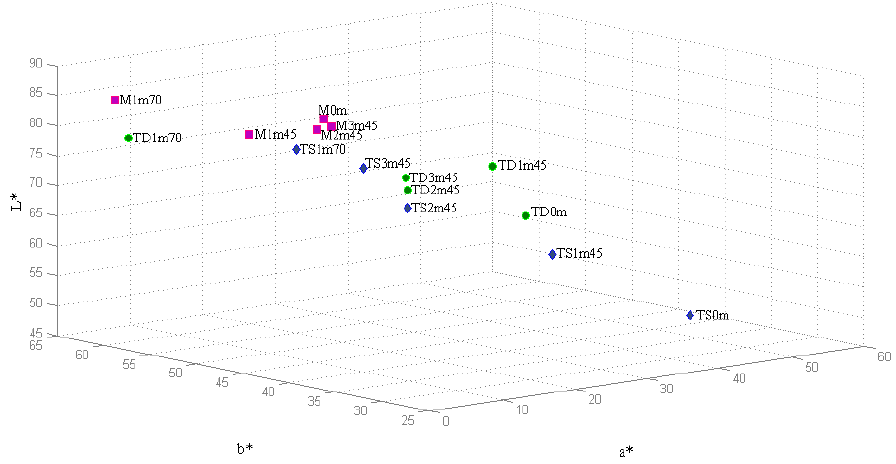
Figure 2. 3D representation of the CIELab chromatic coordinates a* , b* and L* of the Madeira wines submitted to heating at 45 °C (3 months) and 70 °C (1 month). Sample identification: M , TD and TS stand for Malvasia , TNM dry and TNM sweet wines, respectively, while the following two digits correspond to the heating period and the last two represent the heating temperature.